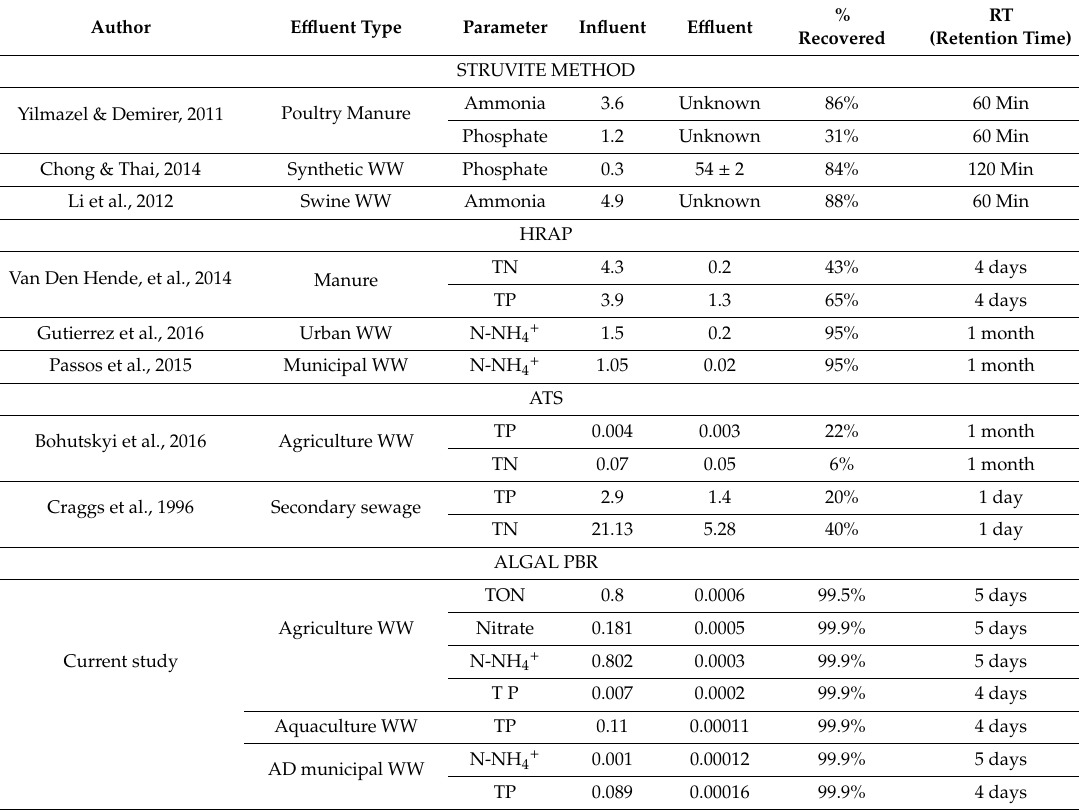
Table5. Bioremediation data (in mMol L − 1 ) from literature [42–49] and from this current study, presenting e ffi ciency of nutrient uptake by algal cultivation, compared with struvite nutrient recovery, HRAP and